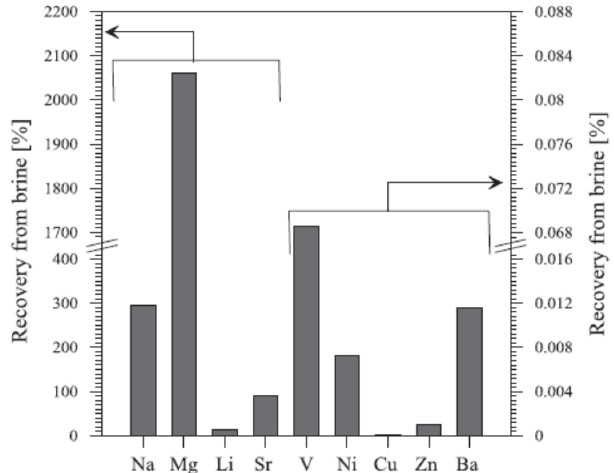
Figure 2. A comparative analysis of potentially recoverable minerals from brine in percentage with respect to their quantity obtained through traditional